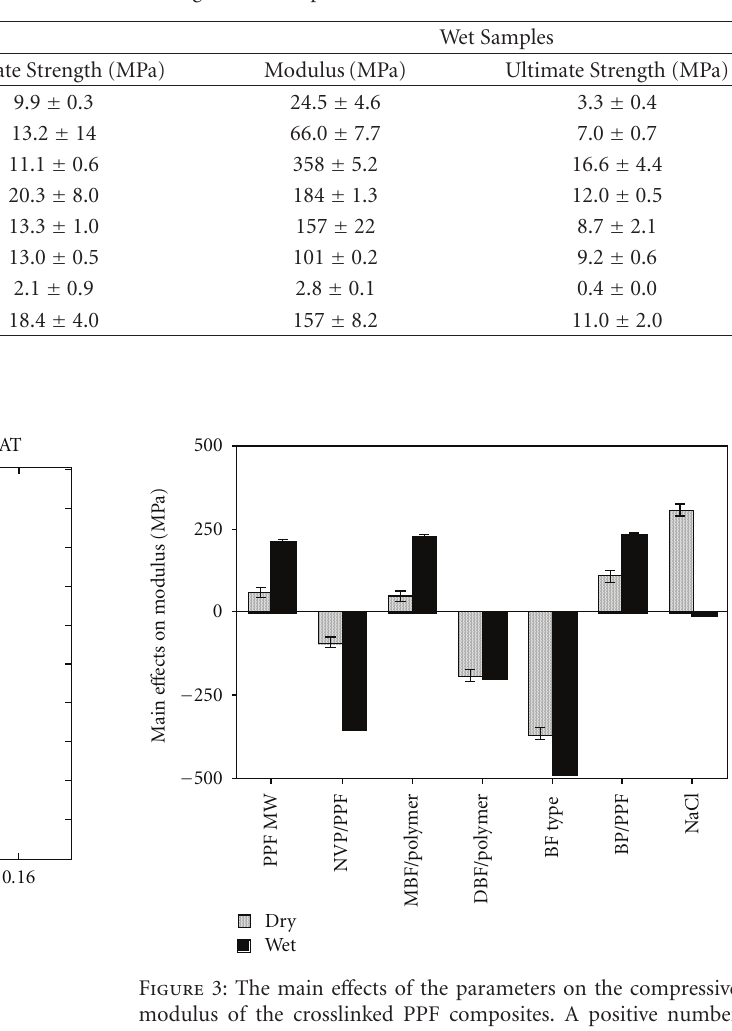
Table 2: Summary of Results for Ultimate Strength and Compressive Modulus.